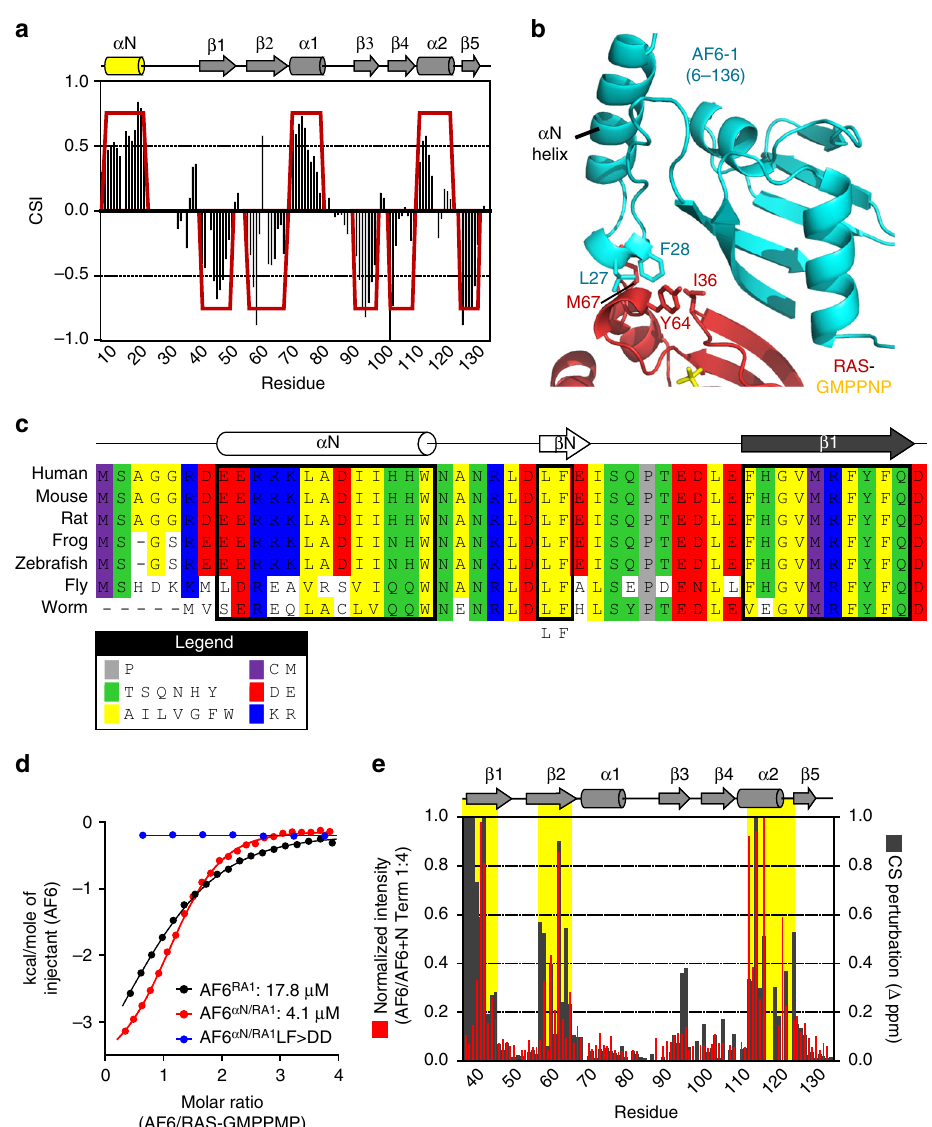
Fig. 2 The α N helix is present in AF6 and augments its binding to RAS. a CSI versus residue number for the AF6 RA1 domain extended 31 residues at the N terminus (6 – 137). Four positive CSI values indicate α -helix; four negative values indicate β -strand. Resulting secondary structure arrangement depicted at top reveals the N-terminal α -helix (yellow). b Ribbons diagram depicting our homology model of the AF6 RA1 domain and α N helix (blue) complexed with RAS-GMPPNP (red-yellow) based on structural alignment with RASSF5-RAS (PDB 3DDC). Leu27 and Phe28, bottom of α N helix, contact switch II residues Met67, Tyr64, and Ile36 of RAS (marked, sticks). c Amino acid alignment of residues upstream of the core RA1 domain in seven evolutionarily conserved AF6 orthologues. A Leu-Phe motif in the loop between α N and β 1 is completely conserved (boxed). d ITC analyses of the interactions between AF6 and RAS-GMPPNP. Core RA1 domain binds RAS with a K d of 17.8 μ M (black), an order of magnitude weaker than most RAS effector interactions. The α N- extended domain exhibits a 4.5-fold increase in af fi nity (red; K d of 4.1 μ M), while a L27D/F28D double mutant showed no heats of association (blue). e Experimental validation of the model by two NMR-based approaches. Left axis, normalized chemical shift perturbations induced in 1 H/ 15 N-HSQC spectra of the AF6 RA1 domain by a puri fi ed AF6 fragment encompassing the α N helix (6 – 36). Right axis, combined chemical shift differences ( Δ p.p.m.) of backbone 1 H/ 15 N resonances from the core RA1 domain (37 – 136) vs extended RA1 domain that incorporates the α N helix (6 – 136). The α N helix in either experiment affects the same three regions (yellow), indicated in domain diagram at